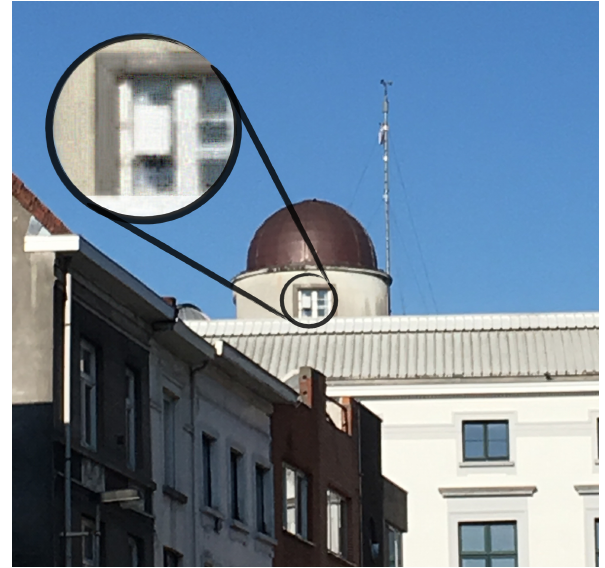
Figure 7. Location of the transmitter at the Armand Pien